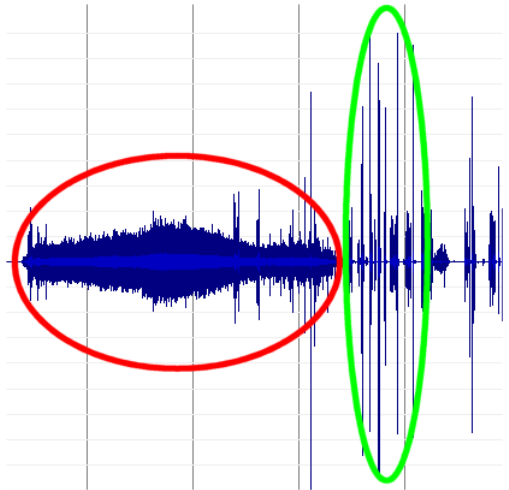
Figure 5. Audio signal recorded by Pi 3 and transmitted to the computer for